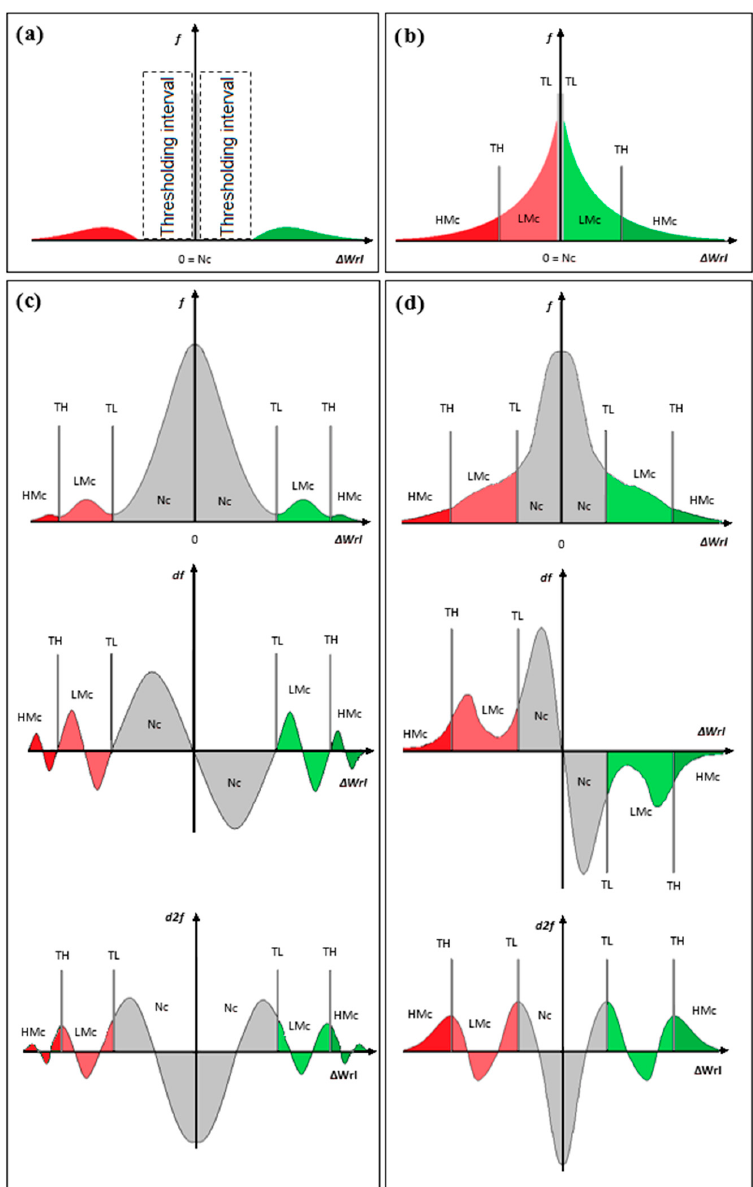
Figure 2. Density slicing classification (Nc—No change; LMc—Low-Magnitude change; HMc—High-Magnitude change) and threshold selections (TL—threshold between Nc-LMc; TH—threshold between LMc-HMc) for different types of frequency ( f ) distribution histograms of ∆ WrI: ( a ) Ideal perfect distribution: no misregistration effects, perfect separation between Nc and change areas; ( b ) Ideal distribution: no misregistration effects, gradual transition from Nc to change; ( c ) Real distribution 1: misregistration effects, gradual well separated transition from Nc to change, and corresponding first ( df ) and second order ( d2f ) derivatives; ( d ) Real distribution 2: misregistration effects, gradual change from Nc to change, and corresponding first and second order derivatives.